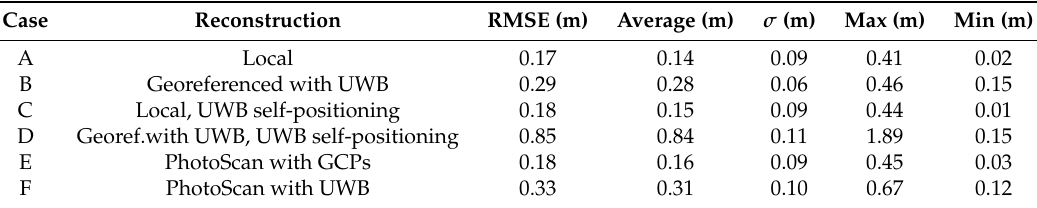
Table 2. Photogrammetric reconstruction accuracy (comparison with TLS